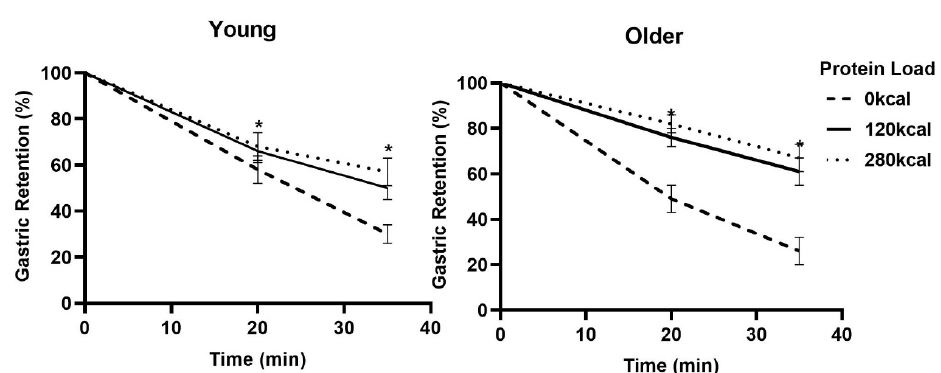
Figure 4. Mean (± SEM) Gastric Retention (%) of drinks containing flavored water (control, ~2 kcal) or whey protein (30 g/120 kcal or 70 g/280 kcal; open bars) in young (left; n = 15) and older (right; n = 15) men. Age and protein load main effects and interaction effects were determined by using repeated-measures ANOVA. * Gastric Retention, calculated based on the antral areas, were larger after both protein drinks compared to control (main effect of age P = 0.27, protein main effect P < 0.001, interaction effect P = 0.091).